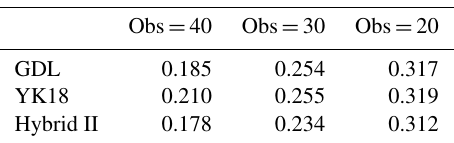
Table 4. The long-term mean analysis RMSE for the variant L96 model (10